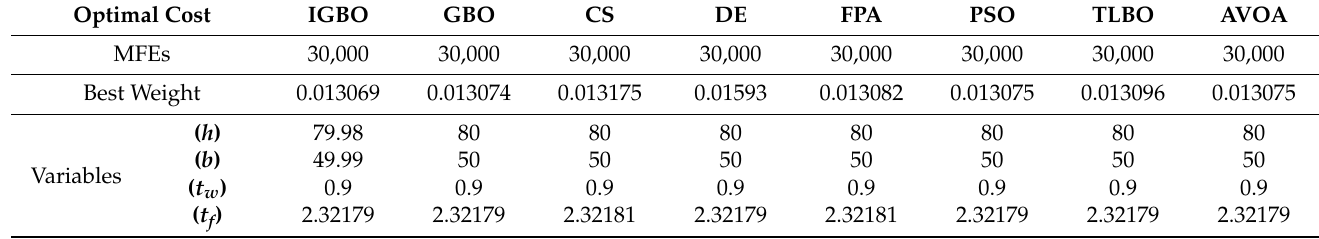
Table 11. Comparison of the best solutions for I-beam design.